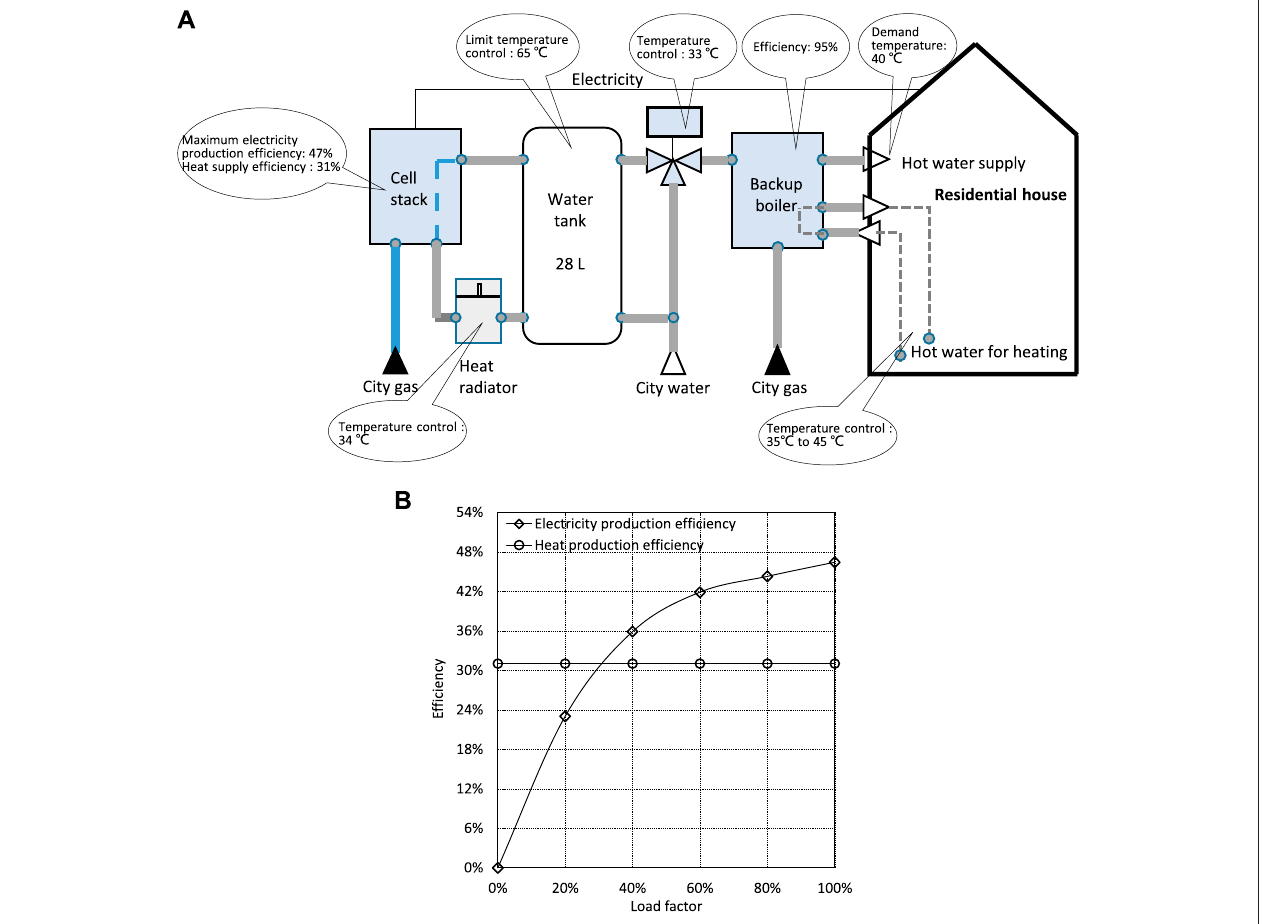
FIGURE 3 | Working procedure and ef fi ciency pattern of the SOFC – CGS: (A) working procedure of the SOFC – CGS and (B) correlation between load factor and ef fi ciency of SOFC – CGS.